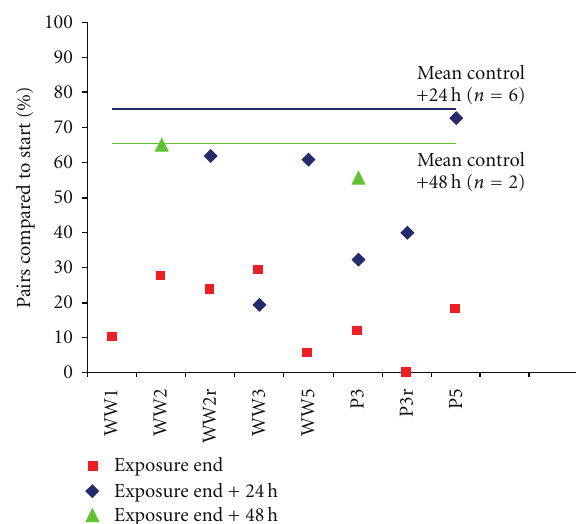
Figure 6: The proportion of pairs re-forming after their return to clean water at exposure end. The proportion of pairs re-forming after transfer to clean water at the initial exposure test end is shown for each separate test occasion. The proportion of pairs present at the start of the first exposure was taken as 100%. The mean control re-pairing is shown for comparison, after 24h in clean water mean of 6 tests (blue line) and after 48 h in clean water mean of 2 tests (green line). Wash water exposures (WW); PEITC exposures (P); proportion of pairs remaining at initial exposure end (red square); after 24h in clean water (green triangle); after 48h in clean water (blue diamond). NB: Re-pairing was not recorded after test WW1. n denotes the number of